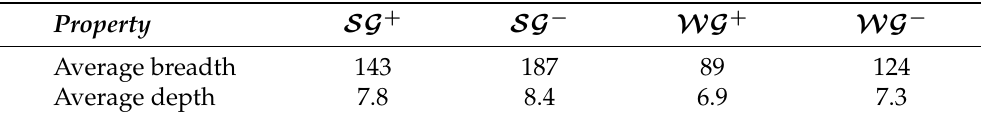
Table 6. Average values of breadth and depth for the graphs SG + , SG − , WG + , and WG −